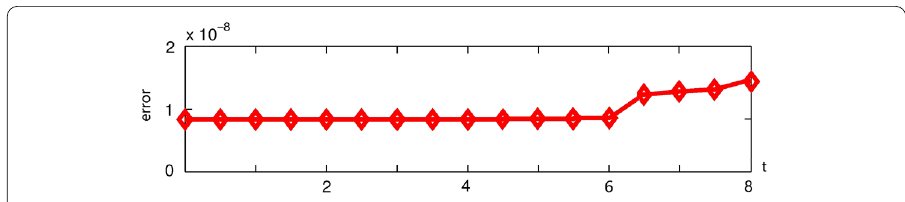
Figure 7 The errors of the SECN energy solutions on 0 ≤ t ≤